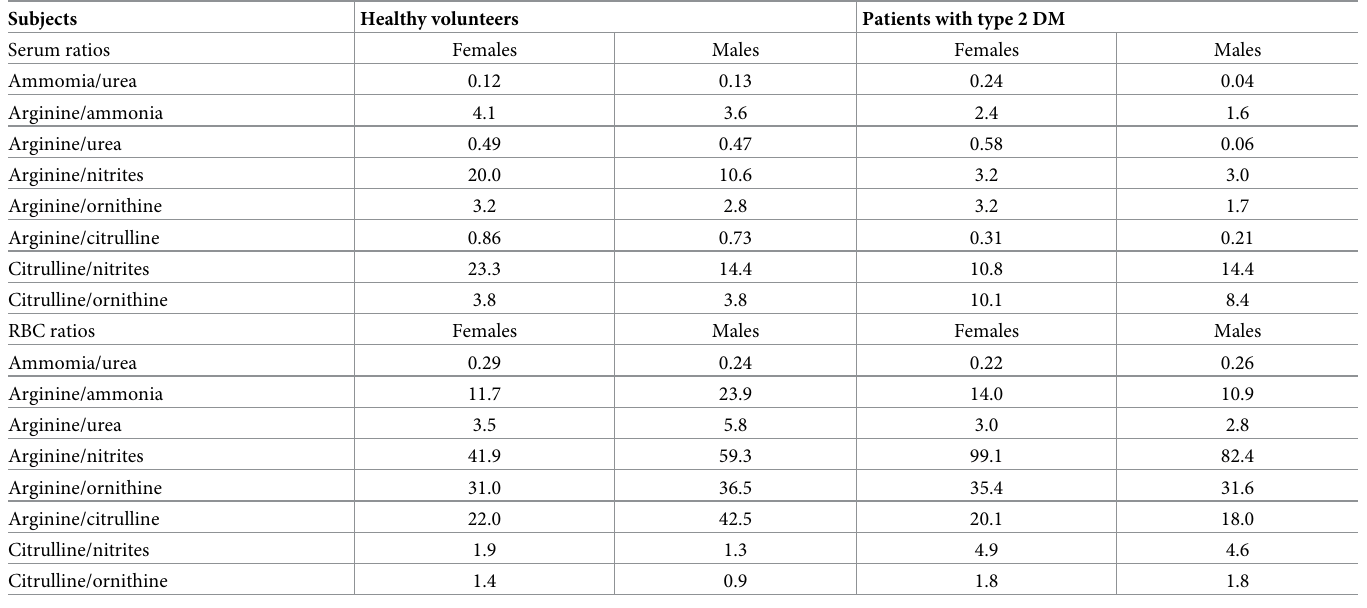
Table 3. Nitrogen-related metabolites and their ratios in serum and RBC of patients with type 2